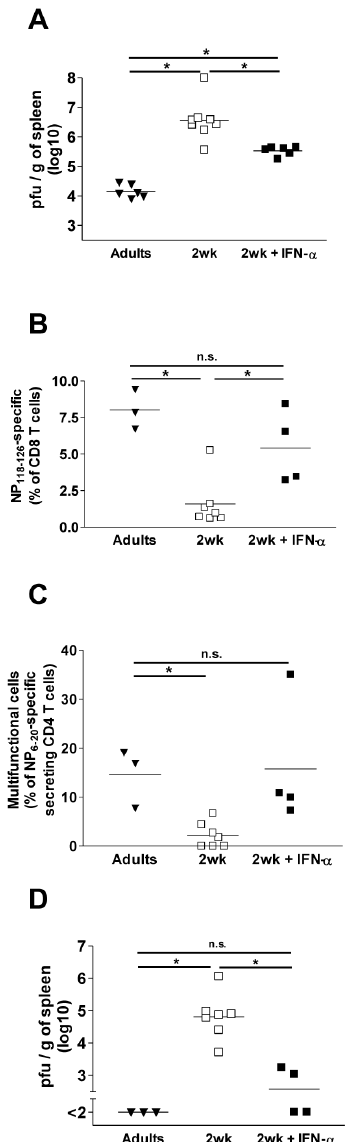
Figure 6. Restoration of viral control and LCMV-specific CD8 + and CD4 + T cell responses by IFN-α supplementation. (A) Spleen virus titer quantified 2 days after LCMV-WE infection of 2-week-old mice supplemented or not with 10,000U of recombinant mouse IFN-α given i.p. at 4h, 8h and 12h after infection. One of two representative experiments is shown. *, p <0.05. (B-D) One injection of long-lasting human recombinant pegylated IFN-α 2a was added 6h after LCMV infection. Analyses were performed 12 days later. (B) % of spleen LCMVnp118-126-specific CD8 + T cells. One of two representative experiments is shown. *, p <0.05. (C) % of LCMVnp6-20-specific IFN-γ, IL-2 and TNF-α secreting CD44 + CD4 + T cells. Percentages obtained in medium controls were subtracted. One of two representative experiments is shown. *, p <0.05. (D) Splenic virus titers. One of two representative experiments is shown. *, p <0.05. doi: